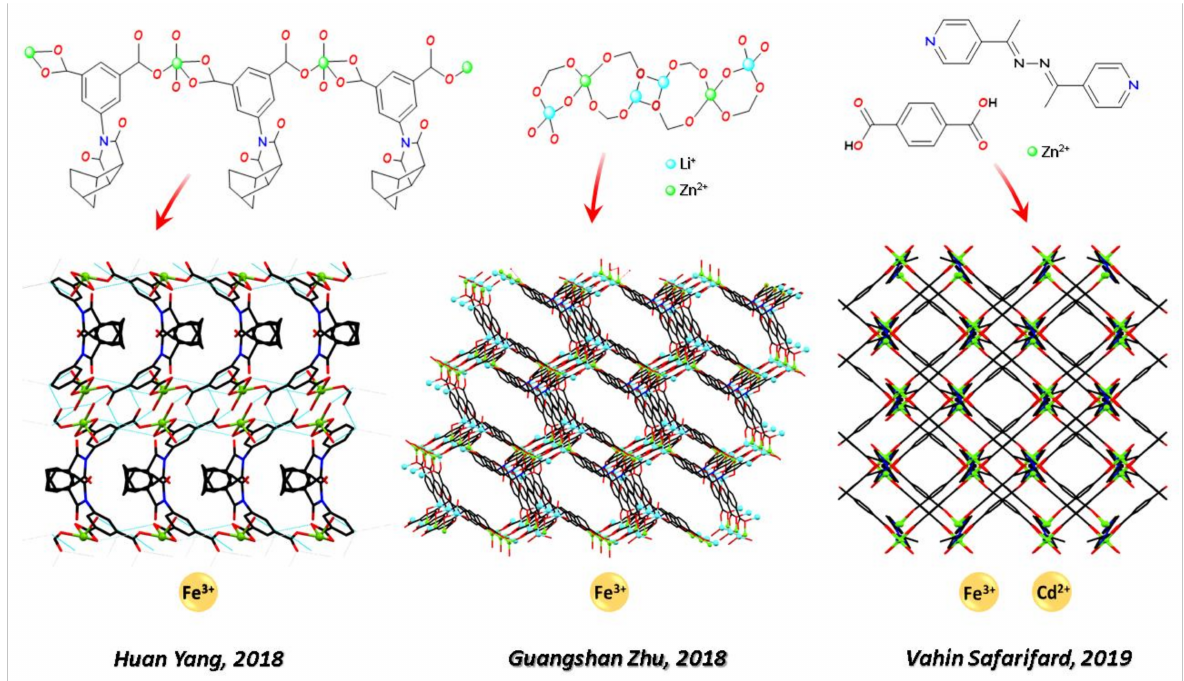
Figure 1. Some representative structures of Zn-CPs for metal cation sensing. Figures readapted by using Mercury software